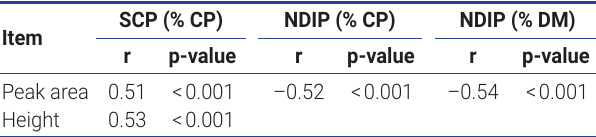
FTIR, Fourier transform infrared; TC, total carbohydrate; CEC, cellulosic compounds; STC, structural carbohydrate area; 1, 2, 3 and 4: correspond to the different peaks; H, peak height; A, peak area; r, correlation coefficient using Spearman; AECP, truly absorbed ECP in the small intestine; ECP, endogenous crude protein in the small intestine.